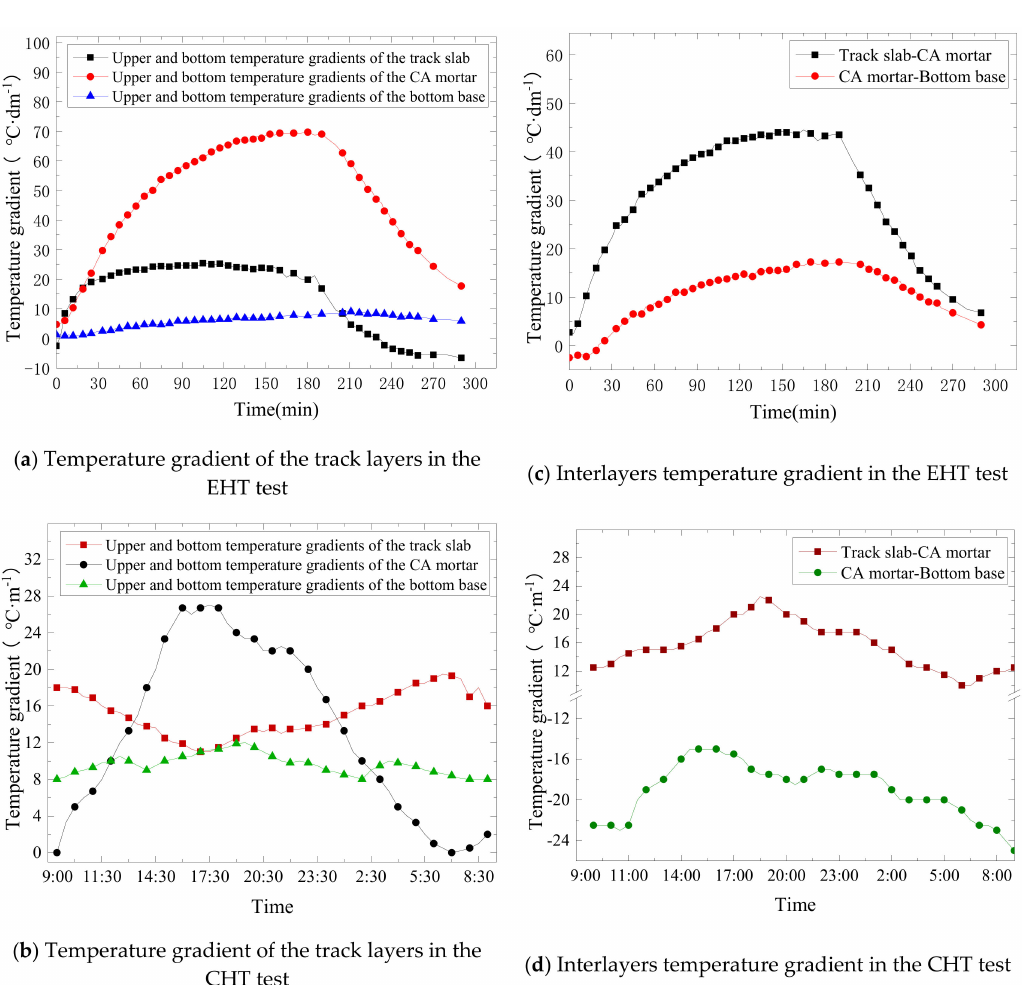
Figure 4. Vertical temperature gradient–time